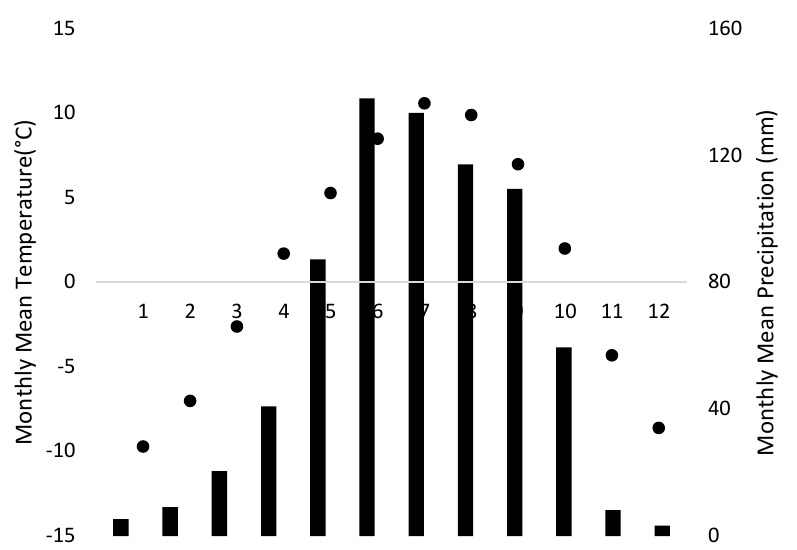
Figure 2. Thirty-Year Average of Monthly Mean Temperature and Precipitation reported by the weather station at Jiuzhi county (elevation 3630 m), 25 km to the northeast of our study site. Given that there is no significant surface water flow into the region, the incoming water is almost entirely from rain, snowmelt, and glaciers (Figure 3). As modern glaciers cover less than 1% of the study region, we assumed their contribution to the regional water budget to be negligible. Thus, we considered rain and snowmelt to be the main sources.